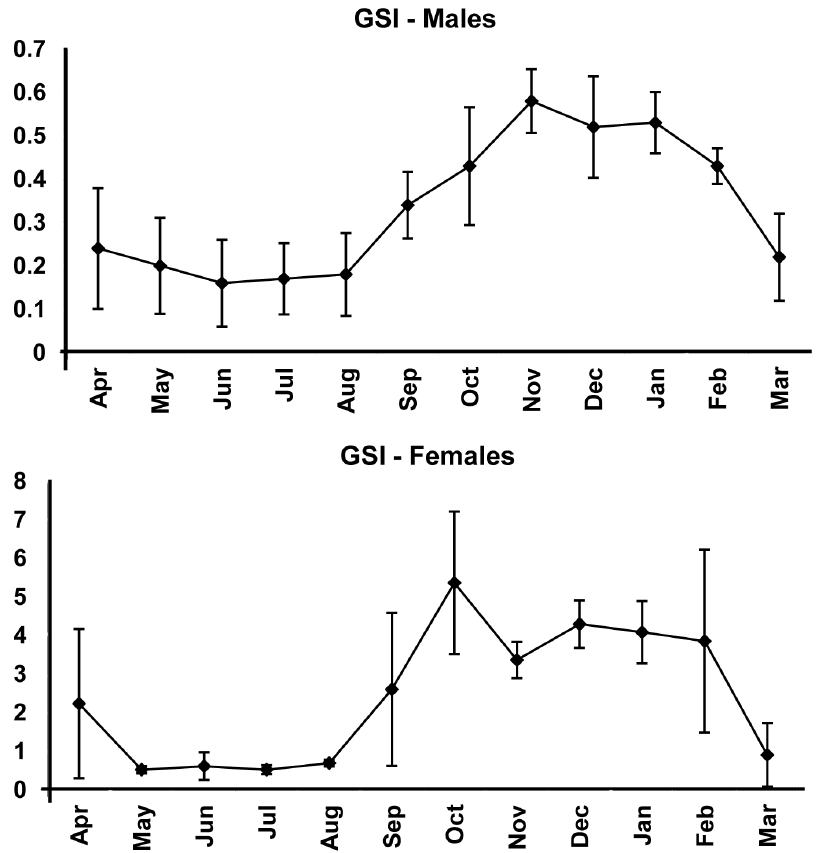
Figure 2. Gonadossomatic index. Monthly variation of mean gonadosomatic index (GSI) for Brachyhypopomus gauderio males and females from April/2005 to March/2006. Vertical bars represent the standard deviation. Numbers above the bars correspond to the numbers of specimens included in the analysis. doi:10.1371/journal.pone.0106515.g002 lateral compression give the distal portion of caudal filament a were collected. The highest relative frequencies of males with feather-like shape – were sampled during all year months except broadened caudal filament occurred in October and November/ February and March/2006 when no males larger than 130 mm 2005 (Fig. 6). Total length of specimens with caudal filament Table 1. Abiotic factors at sampling